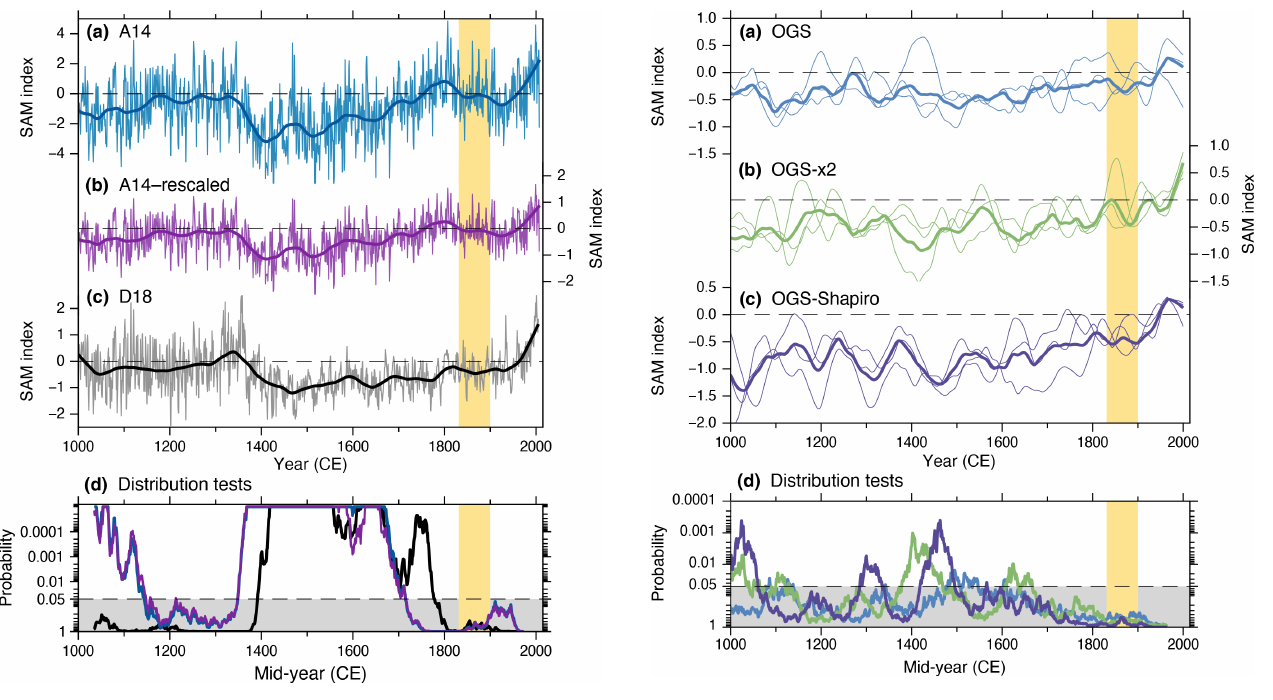
Figure 10. Last millennium SAM reconstructions (a–c) and the sig- nificance of negative shifts in 70-year distributions through time rel- ative to a 70-year pre-industrial reference period (1831–1900) (d) . Annual mean SAM reconstructions (thin curves) and 70-year loess filters (thick curves) for (a) the A14 SAM reconstruction (blue), (b) the A14-rescaled SAM reconstruction (purple; see Fig. 3), and (c) the D18 SAM reconstruction. SAM reconstructions shown relative to 1900–1999CE climatology (dashed horizontal lines). (d) Distribution tests using a Wilcoxon rank-sum test of moving 70-year windows of each SAM reconstruction, shown in panels (a) – (c) , relative to its 70-year pre-industrial reference period (1831– 1900CE; yellow vertical shading). Time series show the probabil- ity for the distribution of sliding test windows being more negative than the distribution in the reference interval; values of P < 0 . 05 are shown with a white background, while values of P ≥ 0 . 05 are shown with a grey background. All three reconstructions show a sig- nificant ( P < 0 . 05) negative shift in the SAM index compared with the 1831–1900 reference interval during the period from approx- imately 1390 to 1715CE. Both versions of the A14 SAM recon- struction also have a significant negative SAM shift prior to around 1140CE.